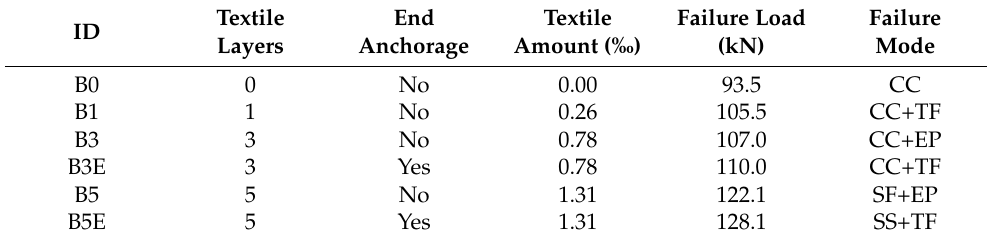
Table 1. Specimen arrangement and test results for bending